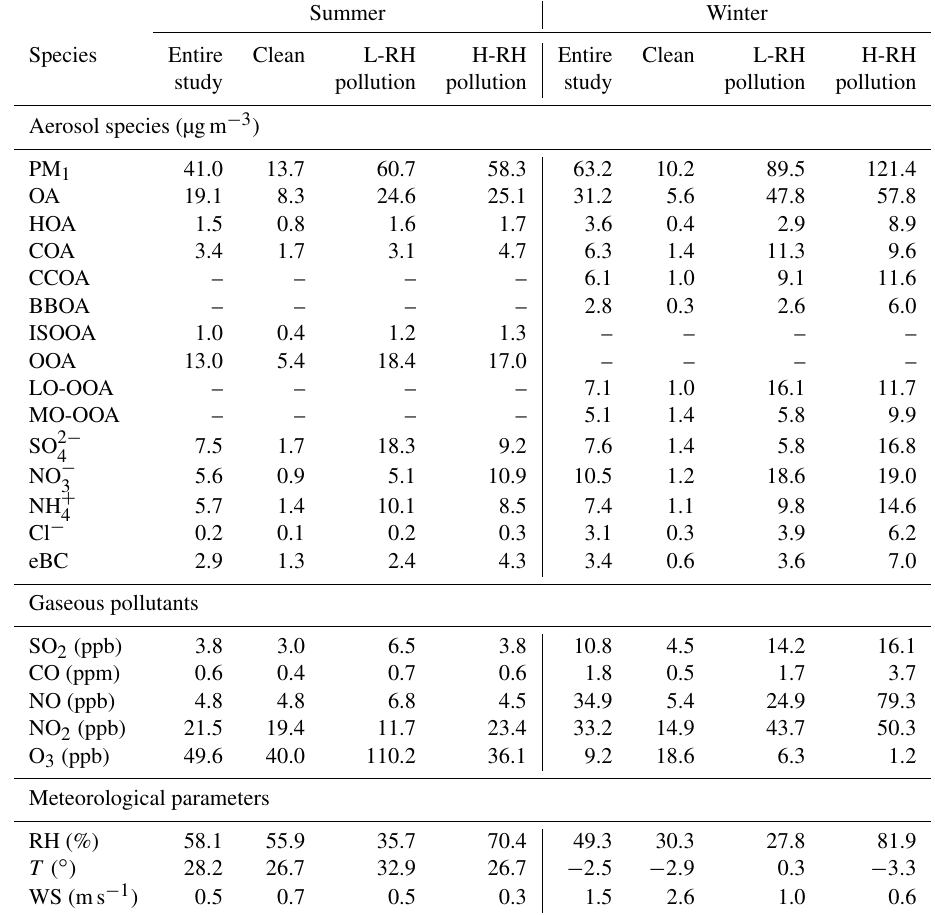
Table 1. Summary of mass concentrations of aerosol species, gaseous pollutants and meteorological parameters during different periods between summer and winter in